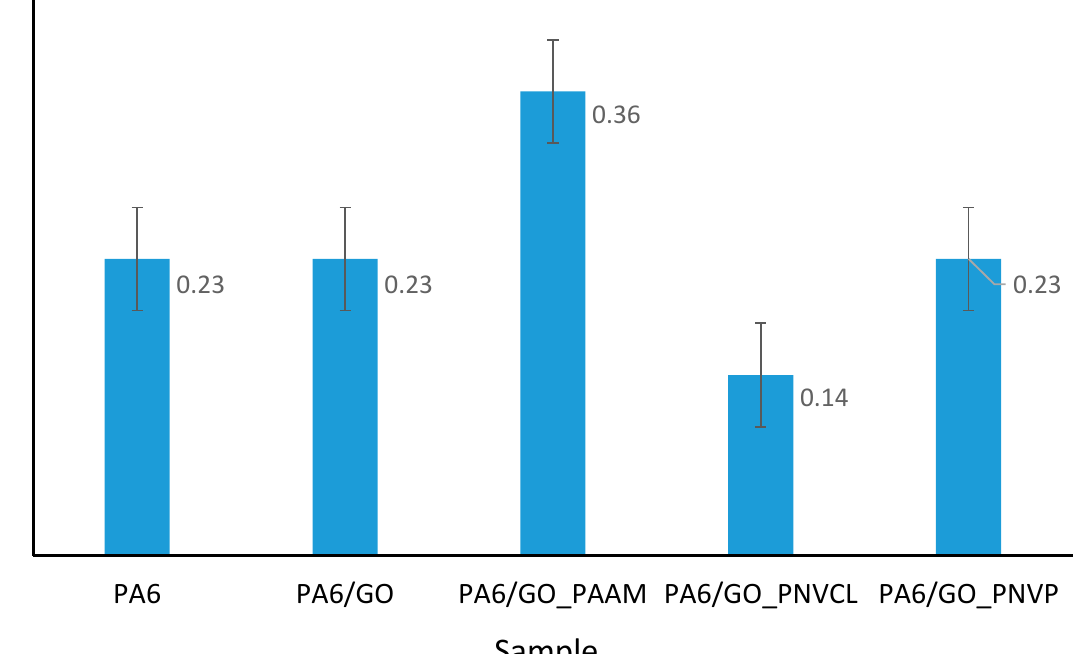
Figure 6. Thermal conductivity of native PA6 and respective nanocomposite samples.